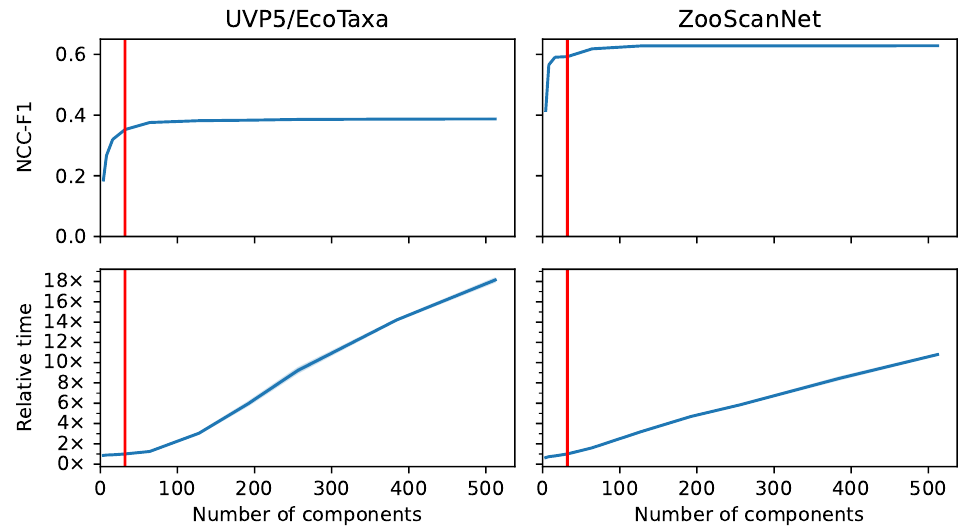
Figure A5. Time to predict and NCC-F1 in relation to different feature dimensionalities. Time is given in units relative to the time required to predict with 32 dimensions. The selected value of 32 dimensions is highlighted in